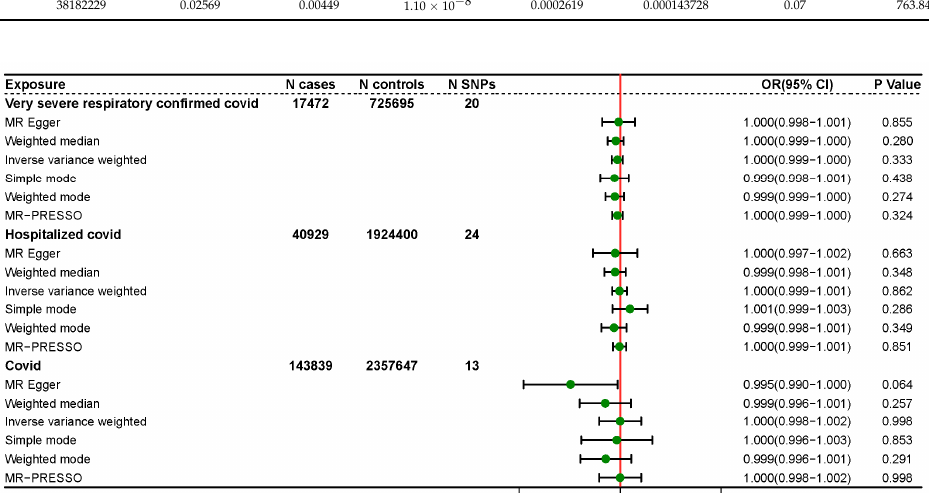
Figure 2. Forest Plots of TSMR Results.